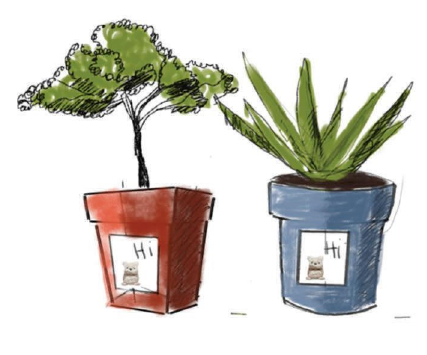
Figure 2: Visual representation of the